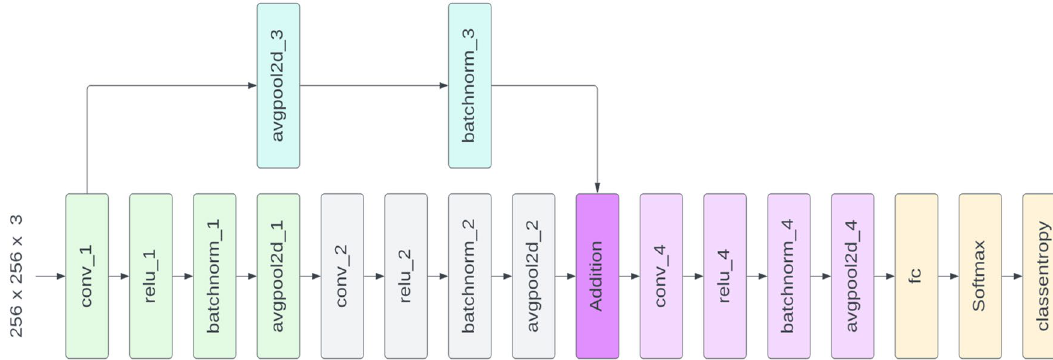
Figure 4. Overview of Proposed